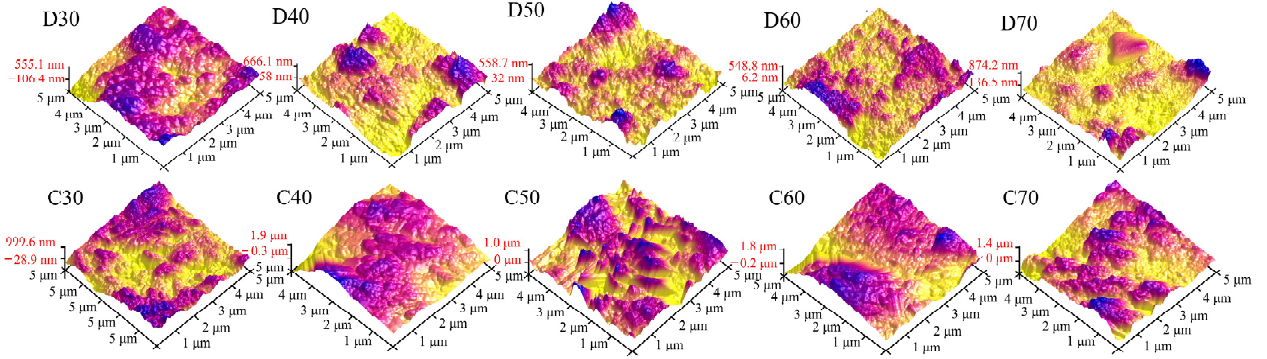
Figure 10. AFM images of the deposition products (D30 − D70) and calcination products (C30 − C70).